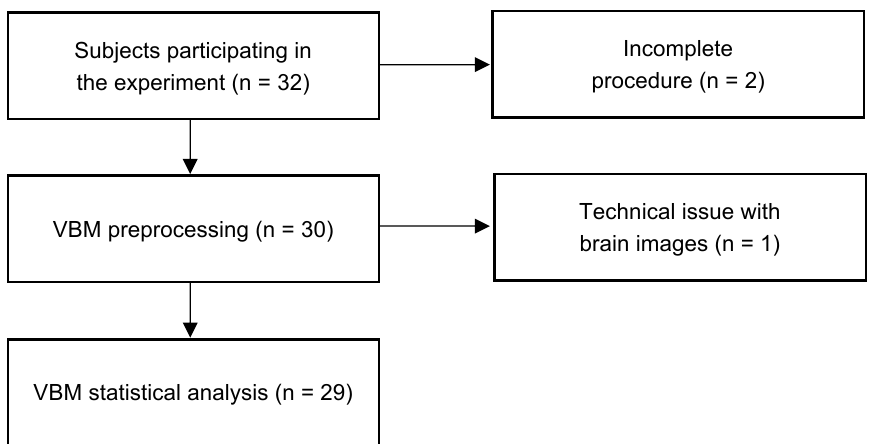
Figure 1. Summary of the study